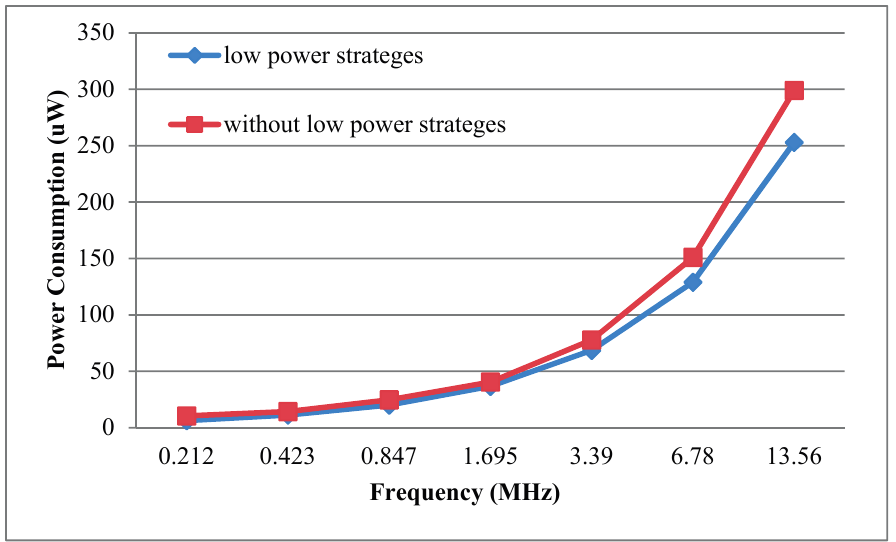
Figure 10. Power consumption under different work frequencies.